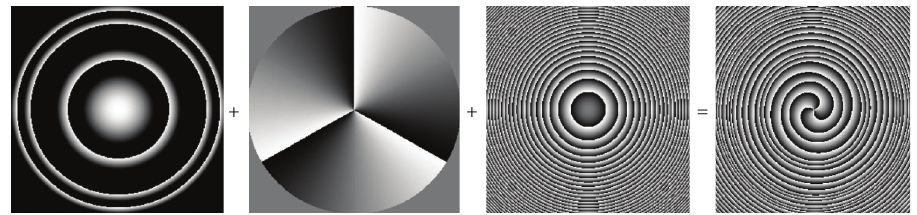
Figure 1: Phase plots of each component which when combined result in Devil’s vortex Fresnel lens (DVFL). Sum of all components, that is, 𝑆 = 2 , 𝑚 = 3 , 𝜆 = 632.8 nm, and 𝑓 = 4 cm, constitutes the final DVFL [15].